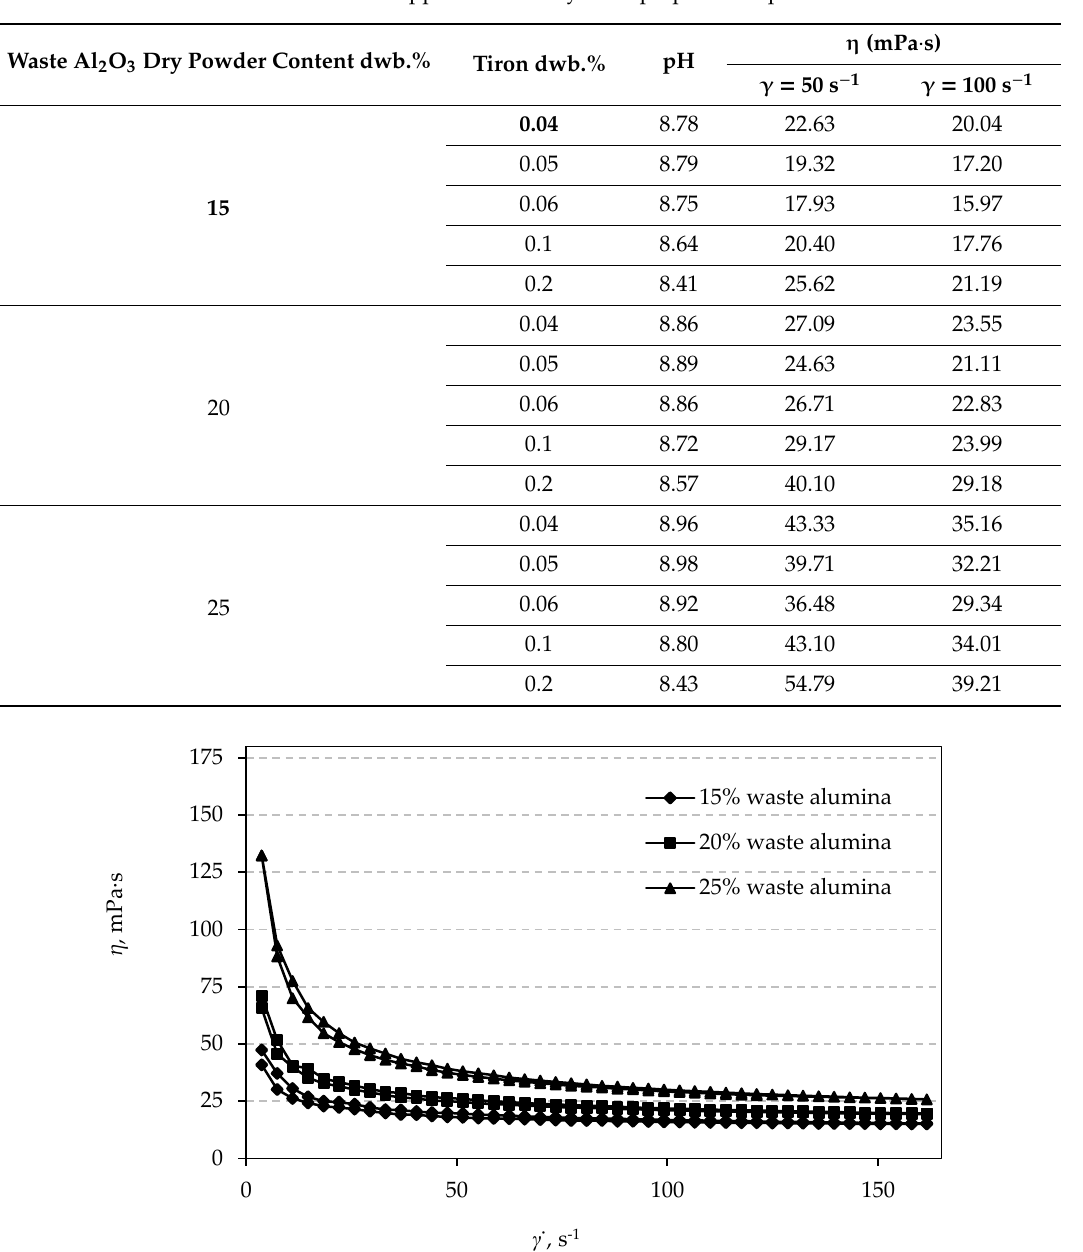
Figure A4. Variation of apparent viscosity of 70 wt.% suspensions with three different composition of waste alumina powder as a function of increasing and decreasing shear rate.